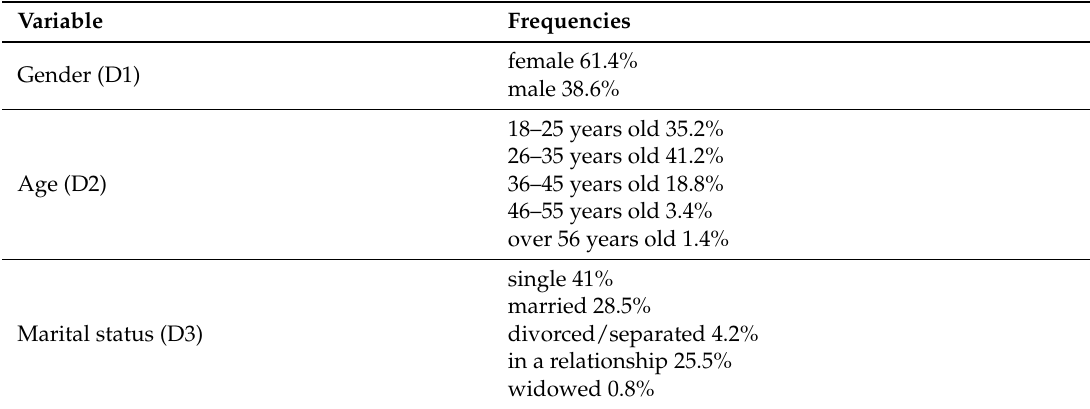
Table 2. Frequencies of the demographic variables